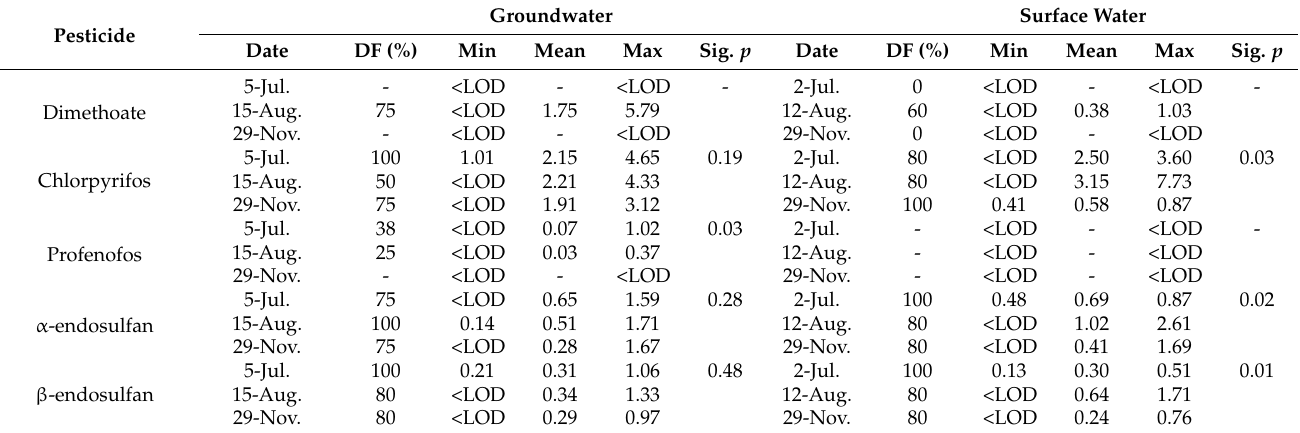
Table 4. Mean, minimum (min.) and maximum (max.) concentrations ( µ g L − 1 ), and detection frequencies of the studied pesticides in water samples from shallow wells and